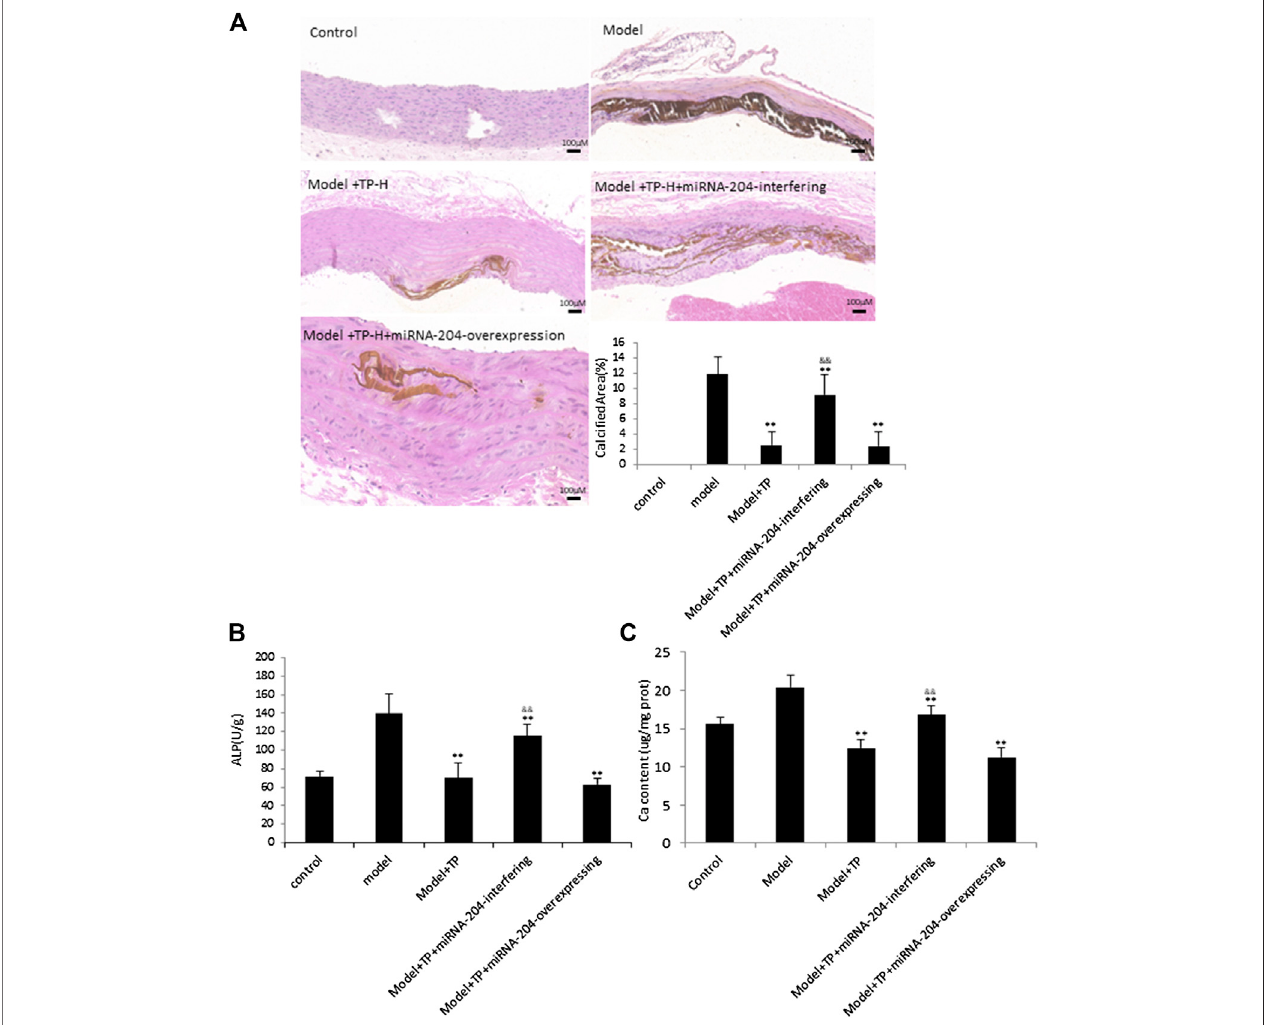
FIGURE 4 | TP protects against vascular calci fi cation induced by VDN in a miRNA-204 increasing manner (A) Left: von Kossa staining shows calcium deposition in aortas of rats; right: bar graphs show quantitative evaluation of the vonkossa calcium area (n (cid:2) 10). ** p < 0.01 compared with model group, && p < 0.01 compared with model + TP group (B &C) Bar graphs show quantitative evaluation of the ALP activity and calcium content, respectively (n (cid:2) 10). * p < 0.05, ** p < 0.01 compared with model group, && p < 0.01 compared with model + TP group.